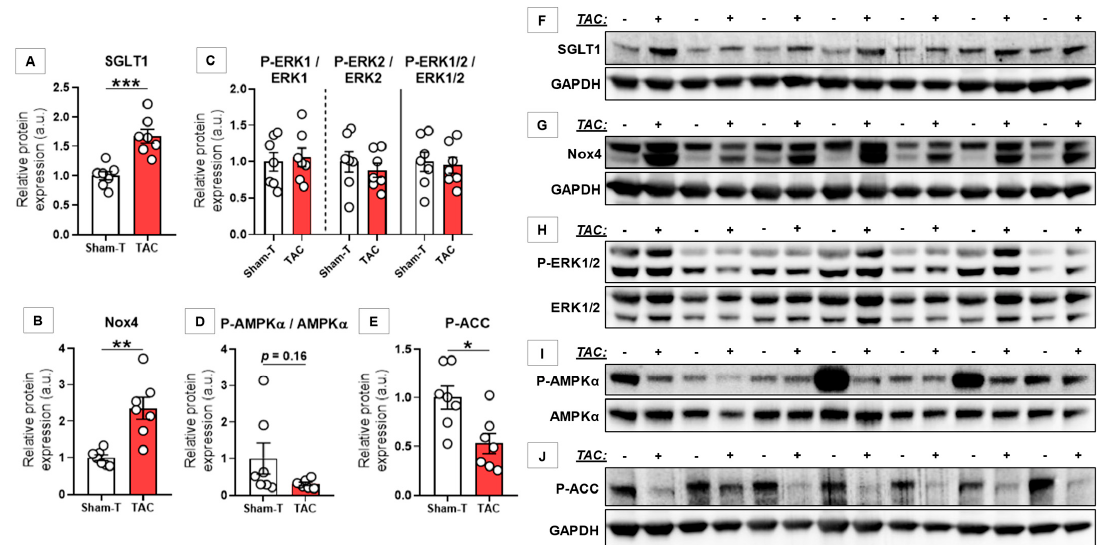
Figure 2. Western blot analysis of left ventricular samples from sham-operated and pressure-overloaded rats with heart failure. ( A–E ) Relative protein expression of left ventricular (LV) sodium-glucose cotransporter 1 (SGLT1); nicotinamide adenine dinucleotide phosphate (NADPH) oxidase isoform Nox4; phosphorylated extracellular matrix-regulated protein kinase 1 and 2 (P-ERK1/2; Thr202/Tyr204), and total ERK1 and 2 ratio separately and in combination; phosphorylated adenosine monophosphate-activated protein kinase α subunit (P-AMPK α ; Thr172) and total AMPK α ratio; and phospho- rylated acetyl coenzyme-A carboxylase (P-ACC; Ser79). ( F–J ) Cropped full-length blots according to the quantification. Following normalization to corresponding housekeeping (GAPDH), protein expression data were normalized to the mean of the respective Sham group to depict fold changes. * p < 0.050, ** p < 0.010, *** p < 0.001.